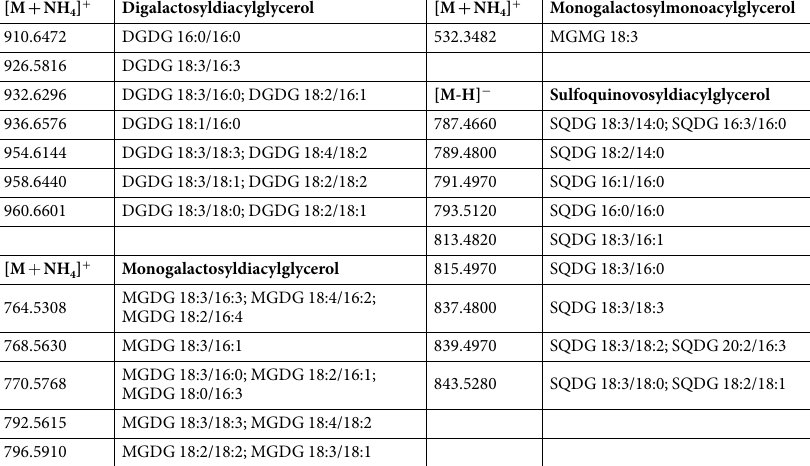
Table 2. Glycolipids molecular species identified by LC-MS and tandem MS (MS/MS) from total lipid extracts of Halimione portulacoides leaves.